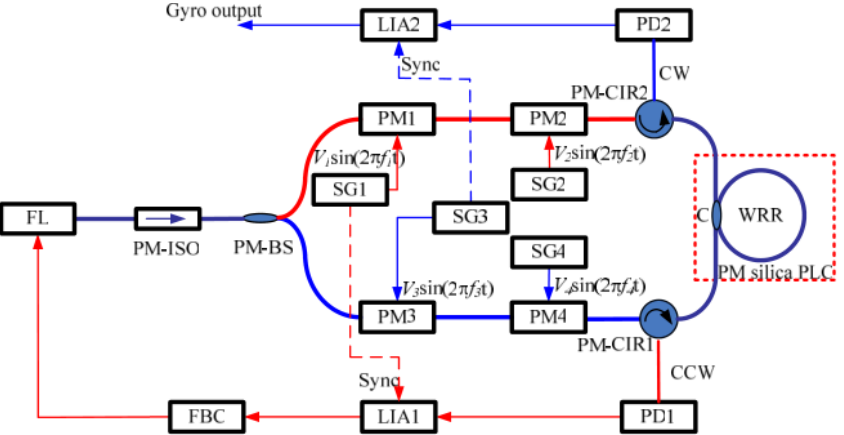
Figure 5. The configuration of the HPMT using the sinusoidal wave. FBC: feedback circuit; PM-ISO: polarization-maintaining isolators; PM-BS: polarization-maintaining beam splitter. Reprinted with permission from ref. [15]. Copyright 2011 The Optical Society.